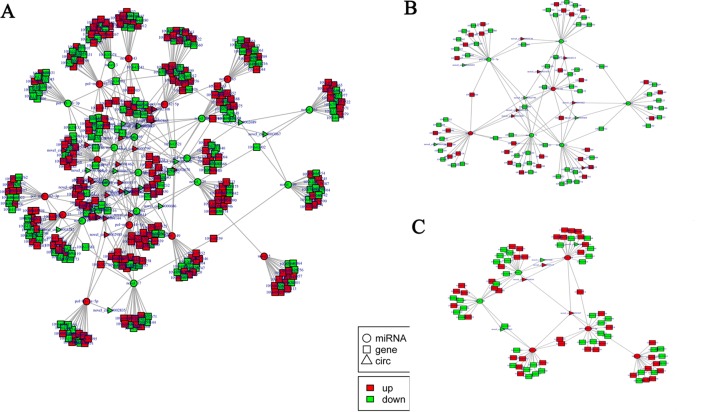
Functional circRNA–miRNA–mRNA regulatory modules between (A) H2, (B) H8, and (C) H12 and H0. CircRNA, miRNA, and mRNA are represented by triangles, circles, and squares, respectively. The red color represents up-regulated, and green color represents down-regulated.